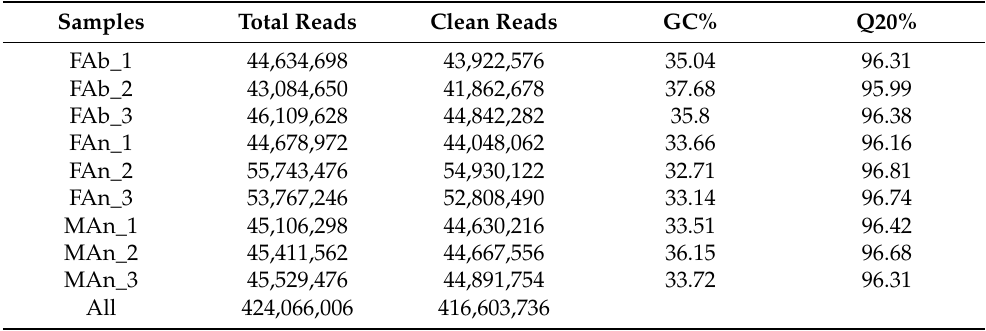
Table 1. Output statistics from the female abdomen (FAb), female antennae (FAn), or male antennae (MAn) of Anastatus japonicus .